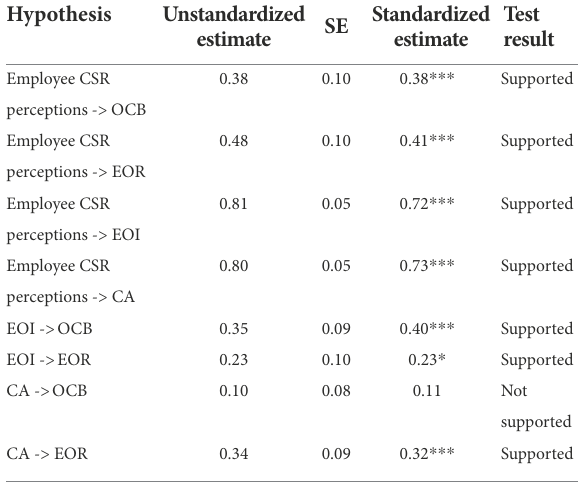
TABLE 2 Results of direct effects.